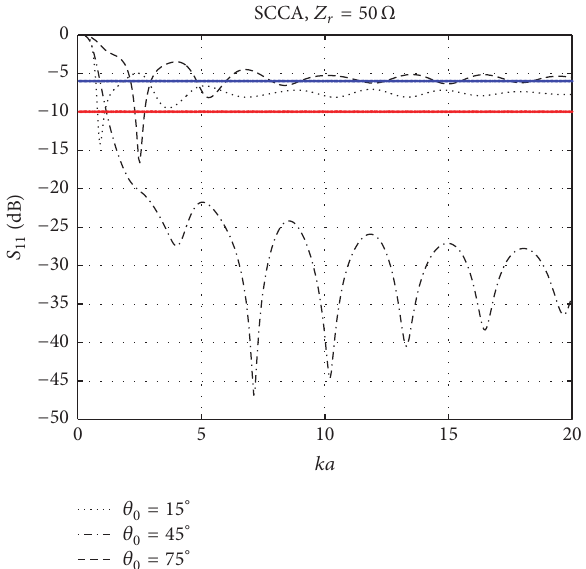
Figure 3: 𝑆 11 of the SCCA versus 𝑘𝑎 for 𝜃 0 = 15 ∘ , 45 ∘ , and 75 ∘ for 𝑍 𝑟 = 50 Ω